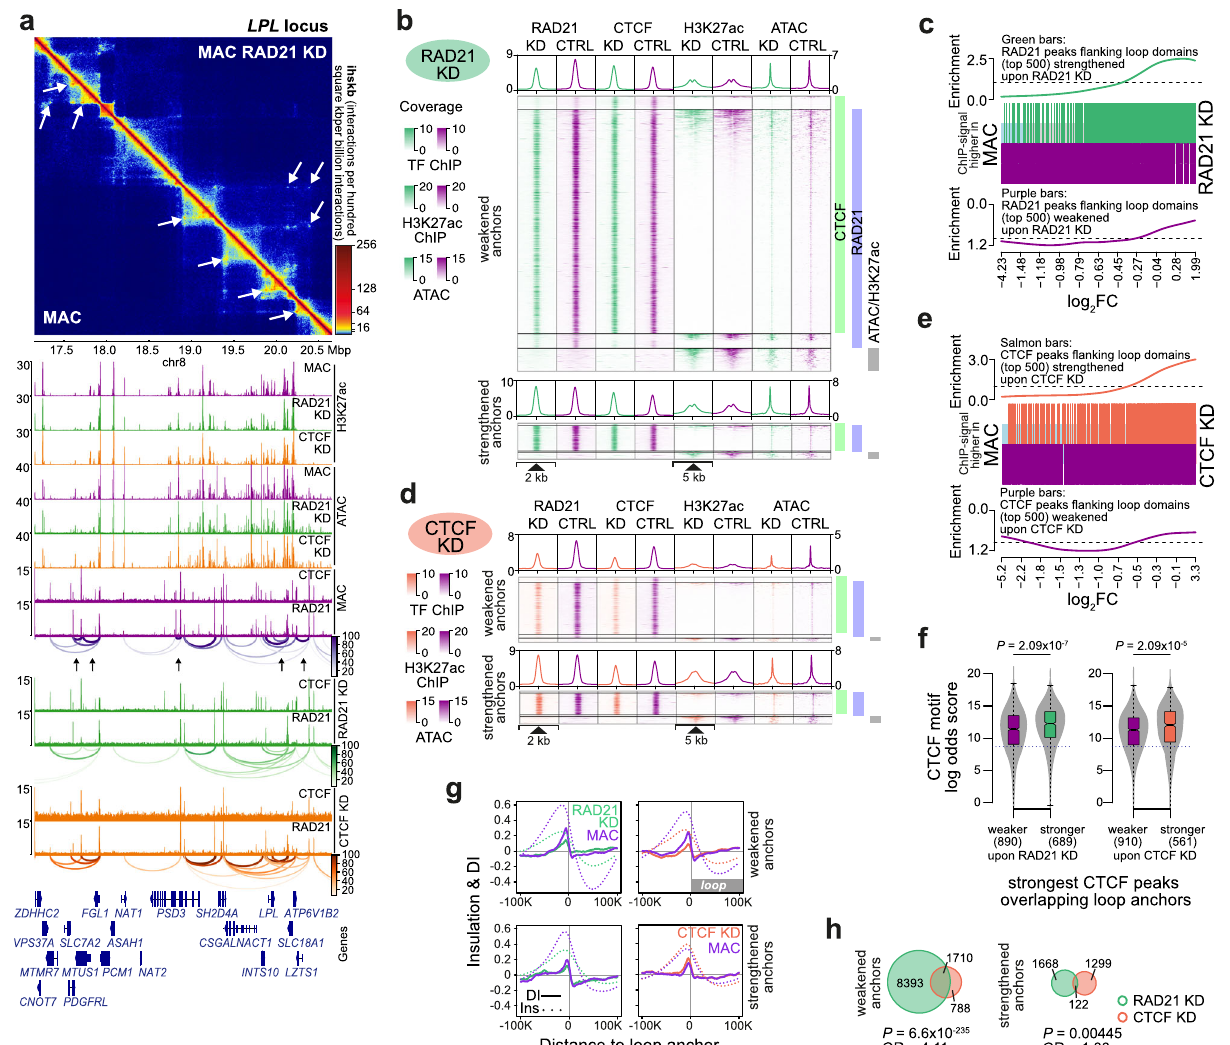
Fig. 6 Properties of loop domain boundaries altered upon cohesin depletion. a Comparative in situ Hi-C interaction map and corresponding genome browser tracks for the LPL locus on Chr.8. Arrows indicate differential loops. b , d Genomic distance distribution across peak-centered loop anchors either strengthened and weakened by RAD21 (in b ) or CTCF knockdown ( d ) in MAC, as described in Fig. 4a. c , e Peak set enrichment of loop anchor-associated RAD21 ( c ) or CTCF peaks ( e ). Enrichment of loop anchor-overlapping peaks that were altered by RAD21 or CTCF knockdown is plotted across all peaks ranked by their signal in siRNA-treated versus control MAC. f Distribution of CTCF motif scores across the indicated peak sets. Solid bars of boxes represent the interquartile ranges (25 – 75%) with an intersection at the median; whiskers represent max/min values; P values: Mann – Whitney U-test, two- sided; dotted line: detection threshold. g Histograms of insulation scores and directionality indices across differential loop anchor regions. h Venn diagrams, P values, and odd ratios for overlaps between loop anchors that are affected by RAD21 or CTCF knockdown in MAC (Fisher ’ s exact test, two-sided). ( b , d , f – h ) Source data are provided as a Source Data fi